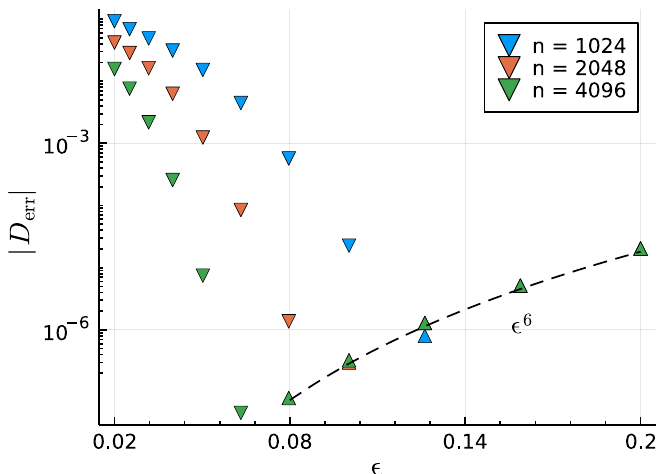
Figure 4. Error in the computed drag versus number of discretization points n using the erf-c regularization. The absolute value of the error is shown, but the direction of the triangle indicates the sign, following the same convention as that in Figure